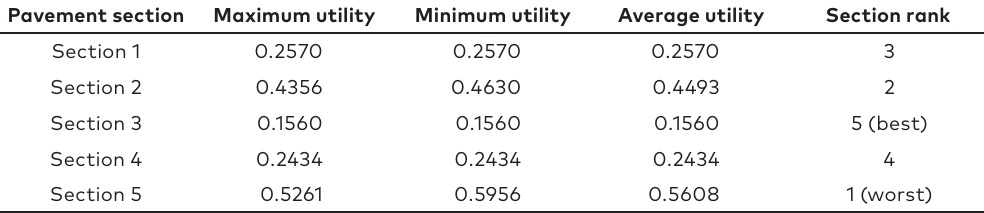
Table 9. Maximum, minimum, and average utilities for the five pavement sections with their